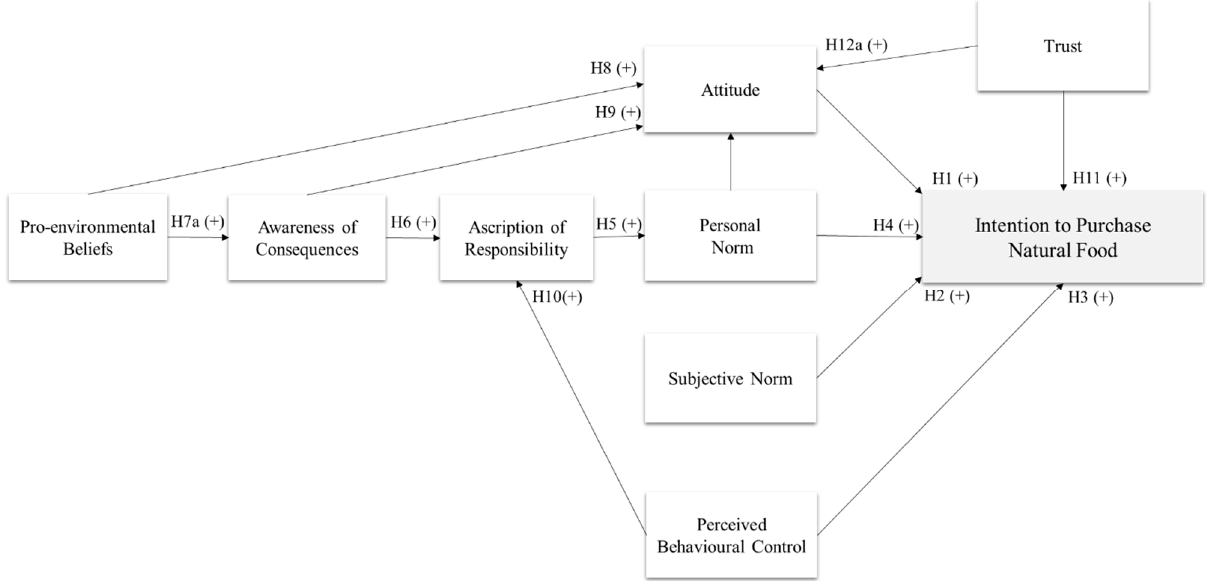
Figure 1. An integrated model to explain natural food purchases. Consistent with the TPB model, we hypothesize that participants’ intention to pur- chase natural food is predicted by their attitude towards natural foods (H1), subjective norm regarding purchasing natural food (H2), and perceived behavioral control (PBC) (H3). Consistent with the VBN model, we also expect that participants’ intention is deter- mined by the sequential chain of personal norm (H4), ascription of responsibility (H5), awareness of consequences of purchasing natural food (H6), pro-environmental beliefs (H7a). To test the predictiveness of the chain of paths proposed by the VBN model, we also verify whether general pro-environmental beliefs have an indirect impact on intention via the sequential mediation of the other beliefs: awareness of consequences, ascription of responsibility, and personal norm